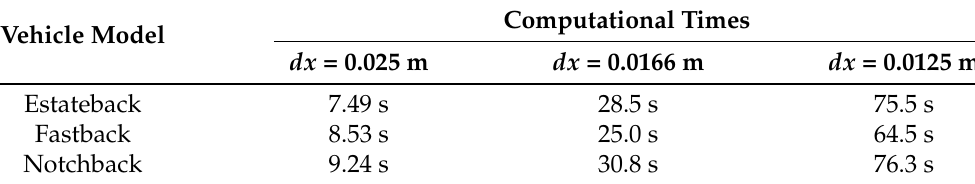
Figure 8. Comparisons of the streamlines calculated by the proposed method with varying mesh sizes. Upper three ( a – c ), middle three ( d – f ), and lower three ( g – i ) figures are the estateback, fastback, and notchback models, respectively. The Mesh sizes are dx = 0.025 m, 0.0166 m, and 0.0125 m, from the left to right figures. Table 4. Summary of the computational times required for the three vehicle models with three mesh resolutions. For all calculations, the BiCGStab method is adopted as the Poisson solver, and 16 threads are utilised for the parallel